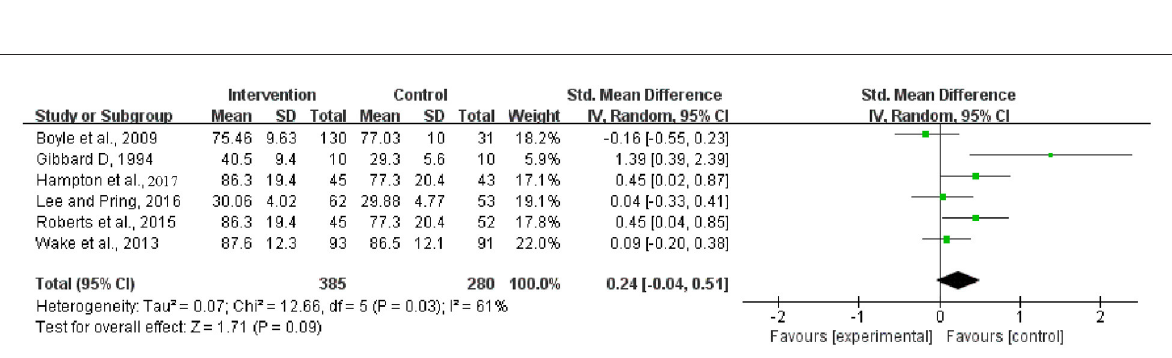
FIGURE4 Meta-analysis outcome of the intervention effect on overall receptive language development. Control, no or delayed